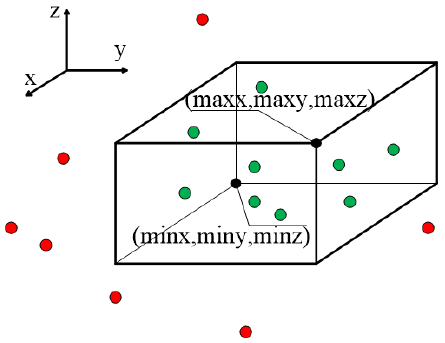
Figure 3. Pass-through filtering is used to segment point cloud data.